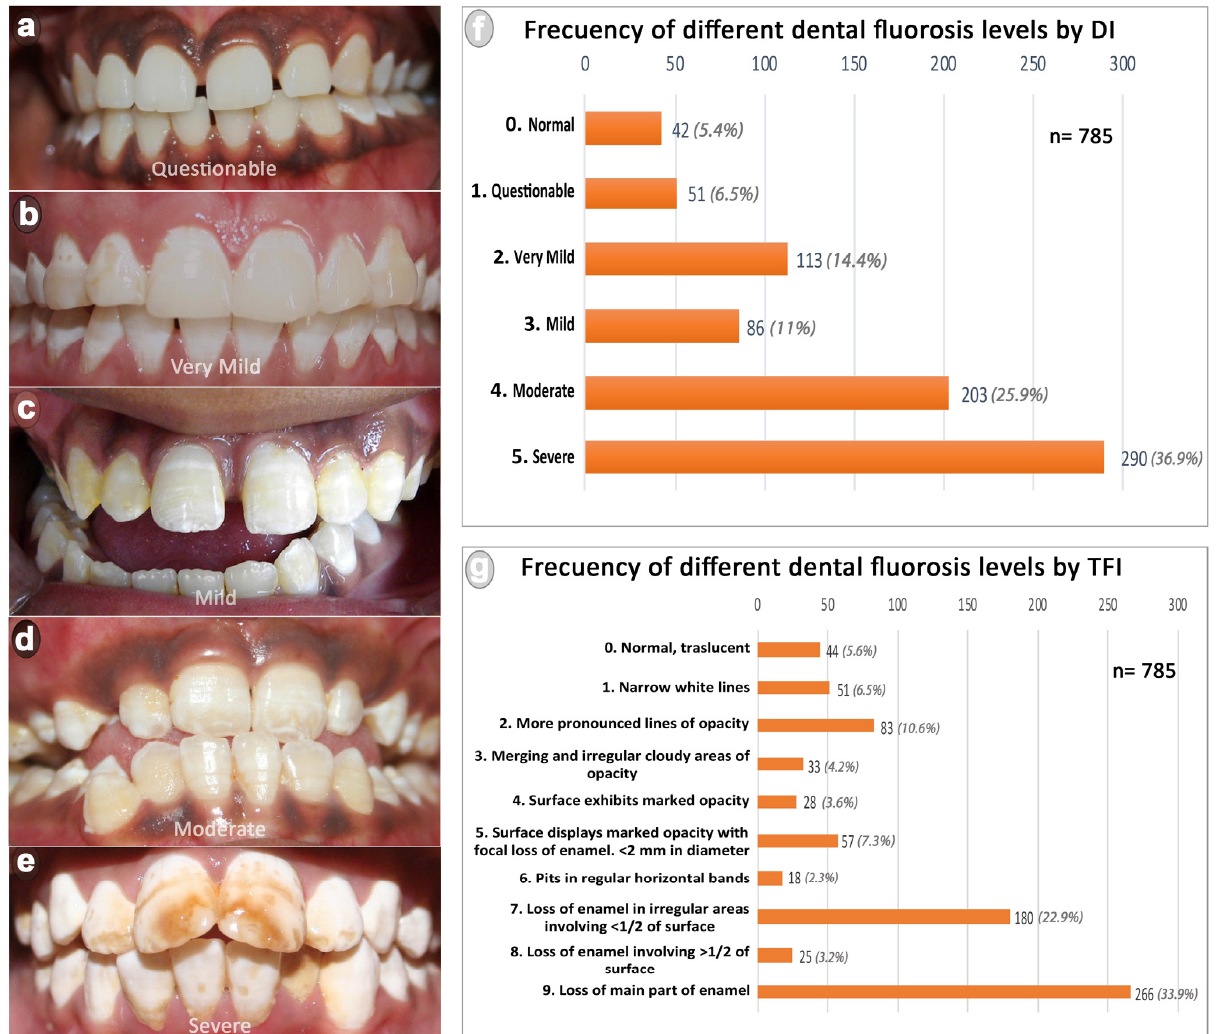
Figure 2. Frequency of different dental fluorosis levels observed in the rural populations of Anantapur. ( a – e ) show fluorosis levels considering the DI (from questionable to severe); ( f ) frequency of dental fluorosis by DI; ( g ) frequency of dental fluorosis by TFI.